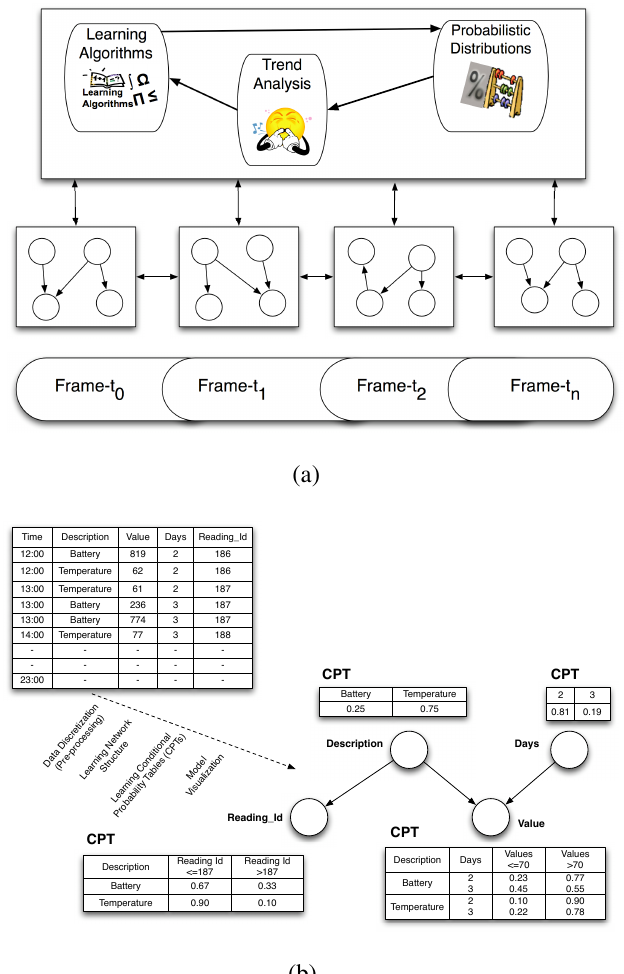
Figure 3. The Situation Recognition Framework. (a) The ESA system Model. (b) The Bayesian Learning